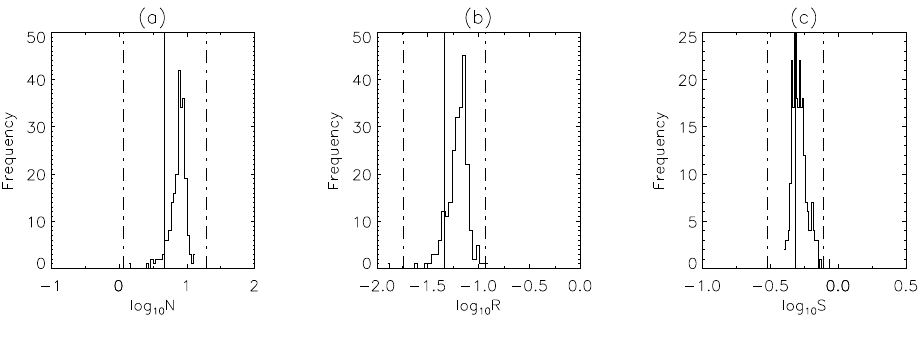
Fig. 5. Histograms of 223 retrieved number densities (a) , median radii (b) and distribution width (c) as retrieved from synthetic aerosol extinction caused by background bimodal aerosols and large noise (maxNS). The vertical lines indicate the a priori mean state (solid), and the a priori mean state plus or minus one standard deviation (dash-dot).